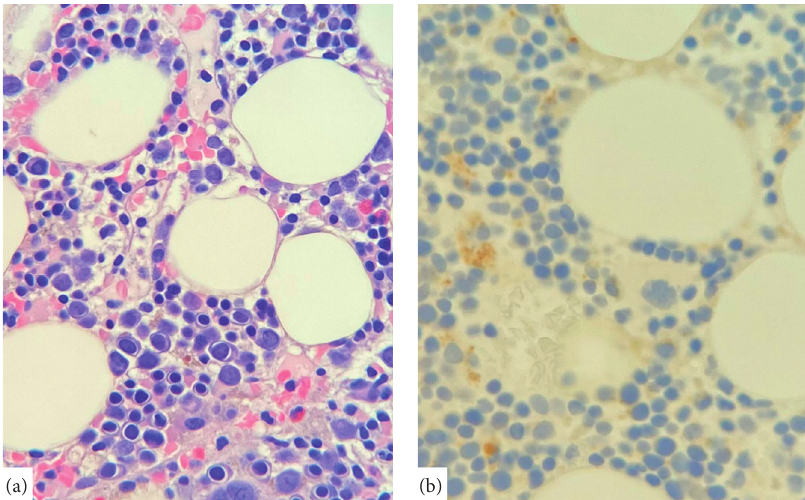
Figure 1: Granulocytic hypoplasia. Bone marrow core biopsy shows complete absence of granulocytic precursor elements on Hematoxylin/ eosin staining (a) and confirmed by immunoperoxidase staining for myeloperoxidase (b). (40x objective).